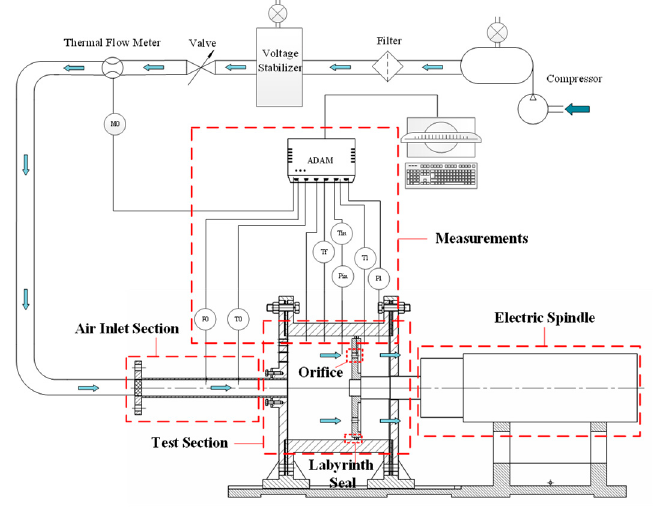
Figure 4. Schematic diagram of the test rig.